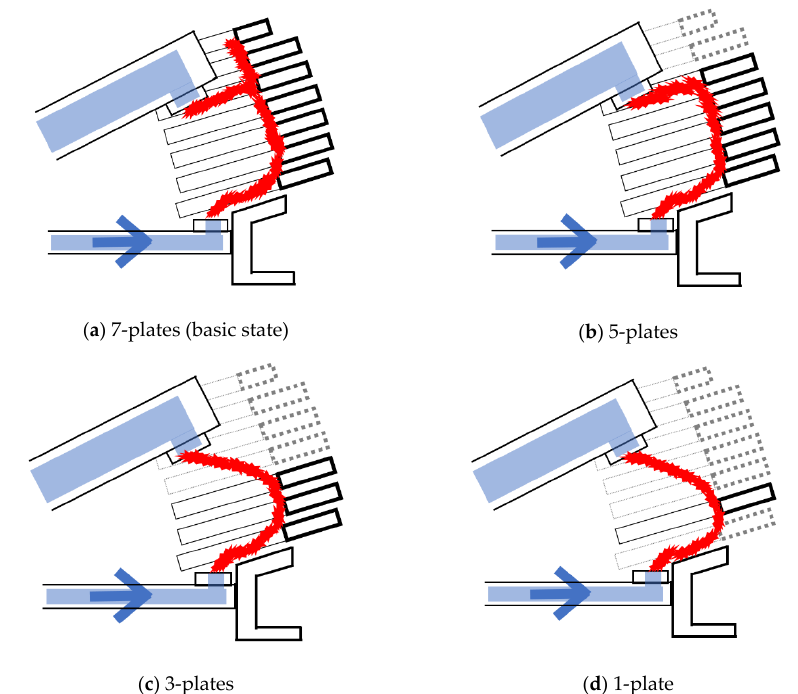
Figure 4. Splitter plate change cases for MCCB modeling.